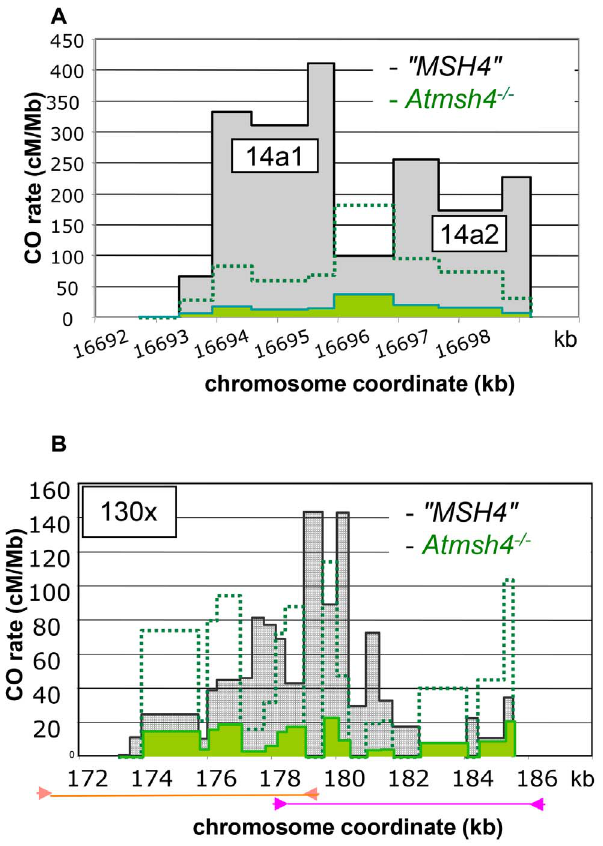
Figure 7. Distribution of CO rates across the 14a (A) and 130 6 (B) hotspots in Atmsh4 2 / 2 . (A) One hundred and eight and 48 COs were analyzed in ‘‘ MSH4 ’’ and Atmsh4 2 / 2 respectively. Grey distribution: ‘‘ MSH4 ’’. Green distribution: Atmsh4 2 / 2 . Green dotted line: 5 6 magnification of the Atmsh4 2 / 2 distribution. (B) Two hundred and forty five and 58 COs were analyzed in ‘‘ MSH4 ’’ and Atmsh4 2 / 2 respectively. Grey distribution: ‘‘ MSH4 ’’. Green distribution: Atmsh4 2 / 2 . The localization of the two overlapping PCRs is shown with orange (left part) and pink lines (right part). Green dotted line: 5 6 magnification of the Atmsh4 2 / 2 distribution.